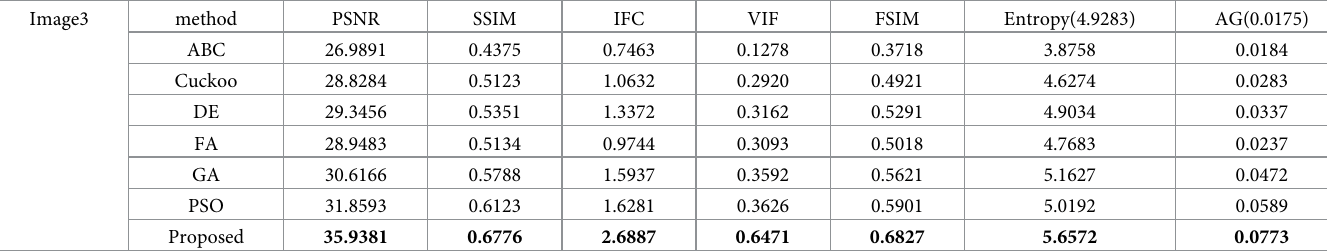
Table 7. The performance evaluation of various image contrast enhancement approaches using test images 3. Image3